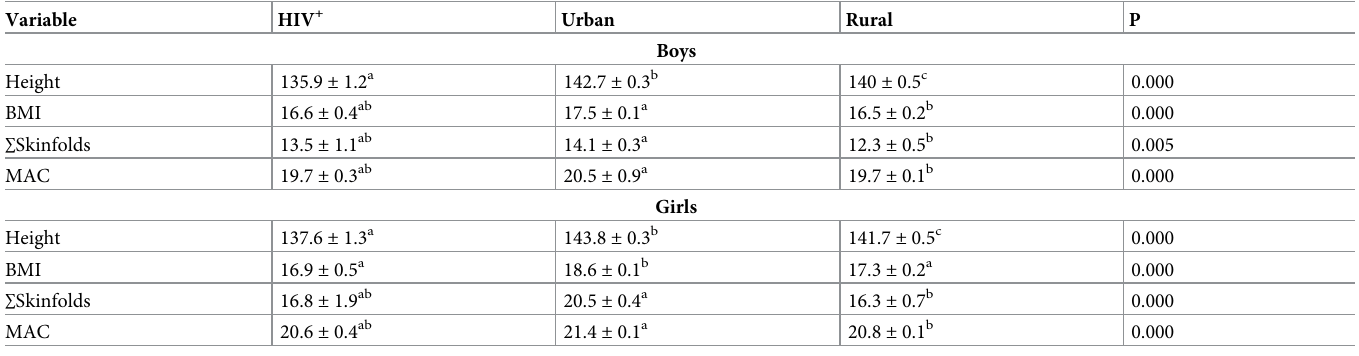
Table 1. Comparision (mean ± sd) of height, body mass index (BMI), sum of tricipital and subscapular skinfolds ( ∑ skinfolds) and mid-arm circumference (MAC) between HIV + and non-HIV + Mozambicans boys and girls from urban and rural settings; p values were generated from an ANCOVA test with age as a covariate. Variable